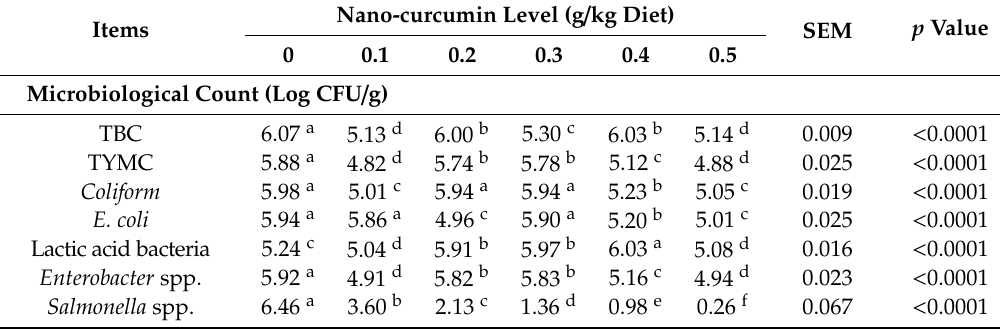
Table 8. Caecal microbiota of growing Japanese quail as a ff ected by dietary nano-curcumin.